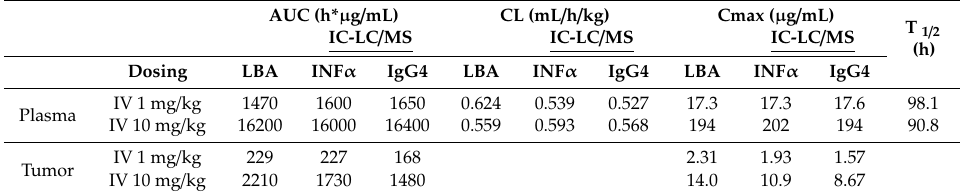
Comparison of pharmacokinetic parameter based on LBA and IC-LC / MS-based assay. TFP concentrations in mouse plasma and LP-1 tumor were measured by electrochemiluminescence LBA assay capturing with anti-human IgG (h + l) and detecting with ruthenylated anti-human interferon alpha or immunocapture-LC / MS assay capturing with anti-human IgG (Fc specific) and detecting with interferon alpha and human IgG4 specific peptides. The values were expressed as mean values because the plasma and tumor samples were harvested as terminal sampling from each